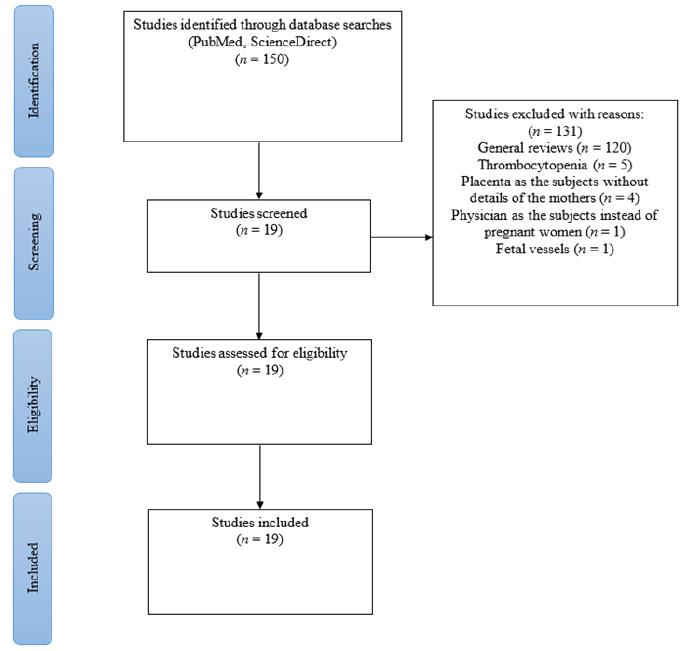
Figure 1. PRISMA chart.